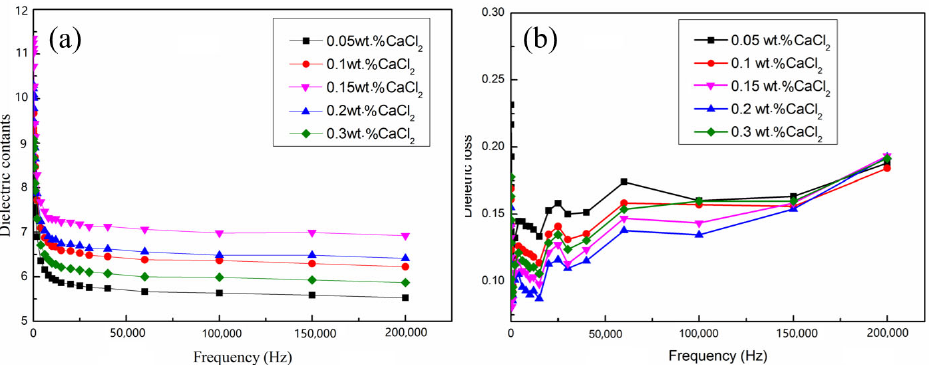
Figure 7. Dielectric properties of PVDF/CaCl 2 composite films ( a ) dielectric constant, ( b ) dielectric loss.